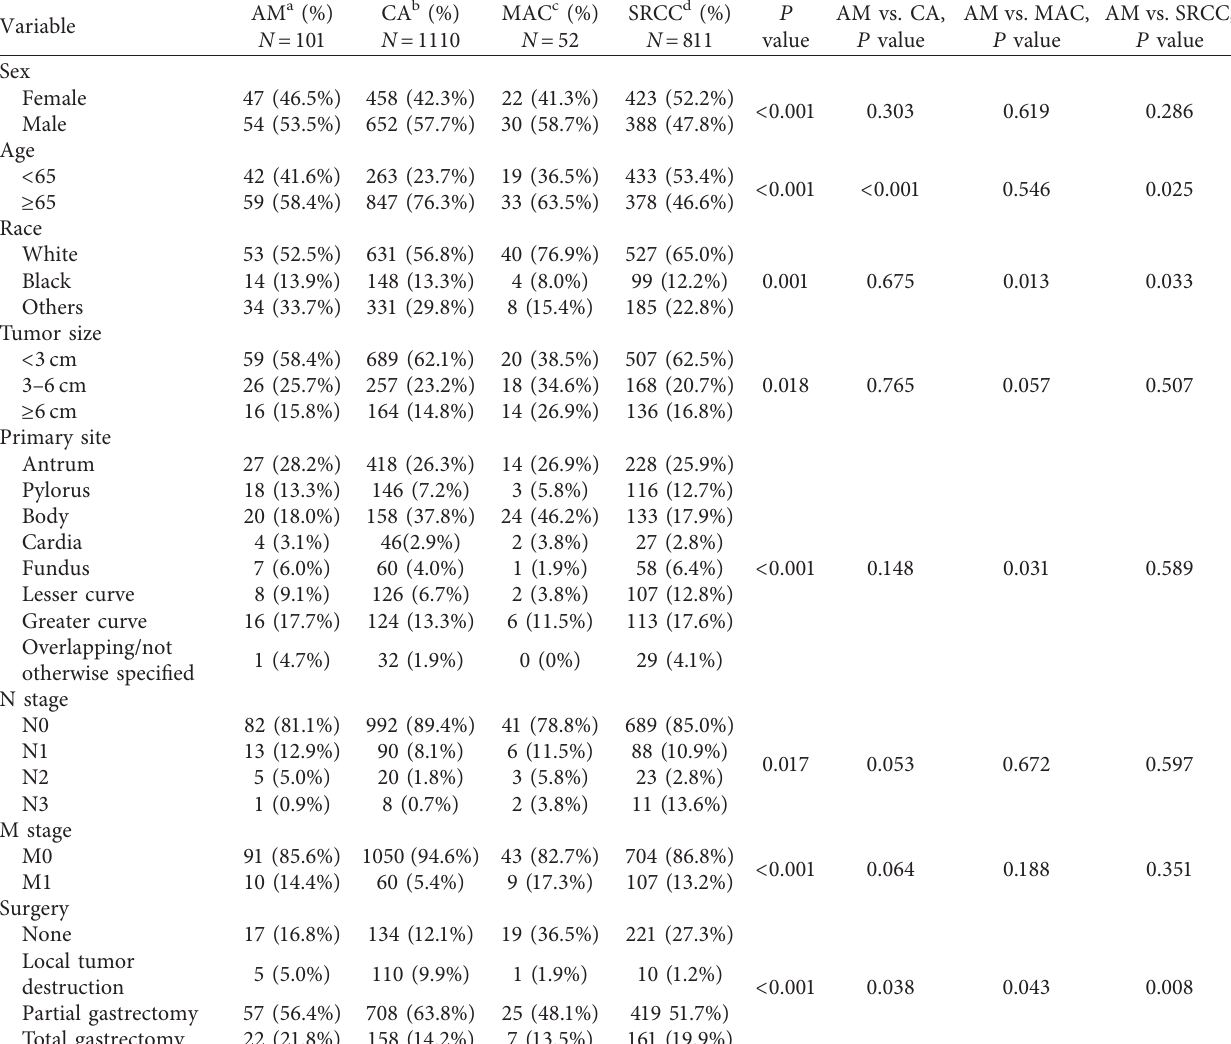
Table 1: Comparisons of the clinicopathologic features between adenocarcinoma with mixed subtypes and other histologic types, including classical adenocarcinoma, mucinous adenocarcinoma, and signet-ring cell carcinoma in early gastric cancer.